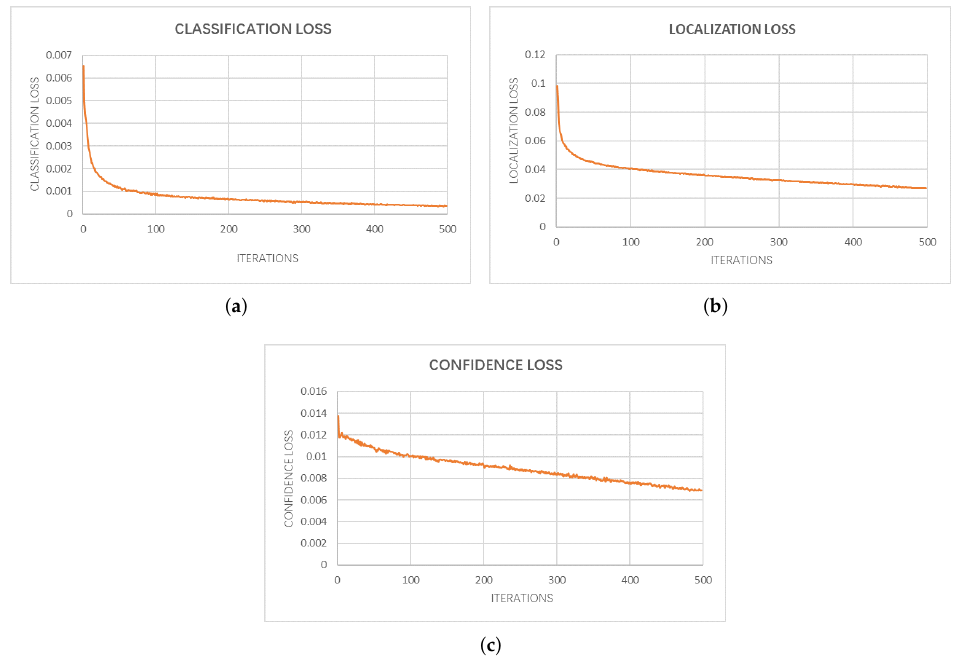
Figure 12. The variation curves of the loss values: ( a ) classification loss; ( b ) localization loss; ( c ) confidence